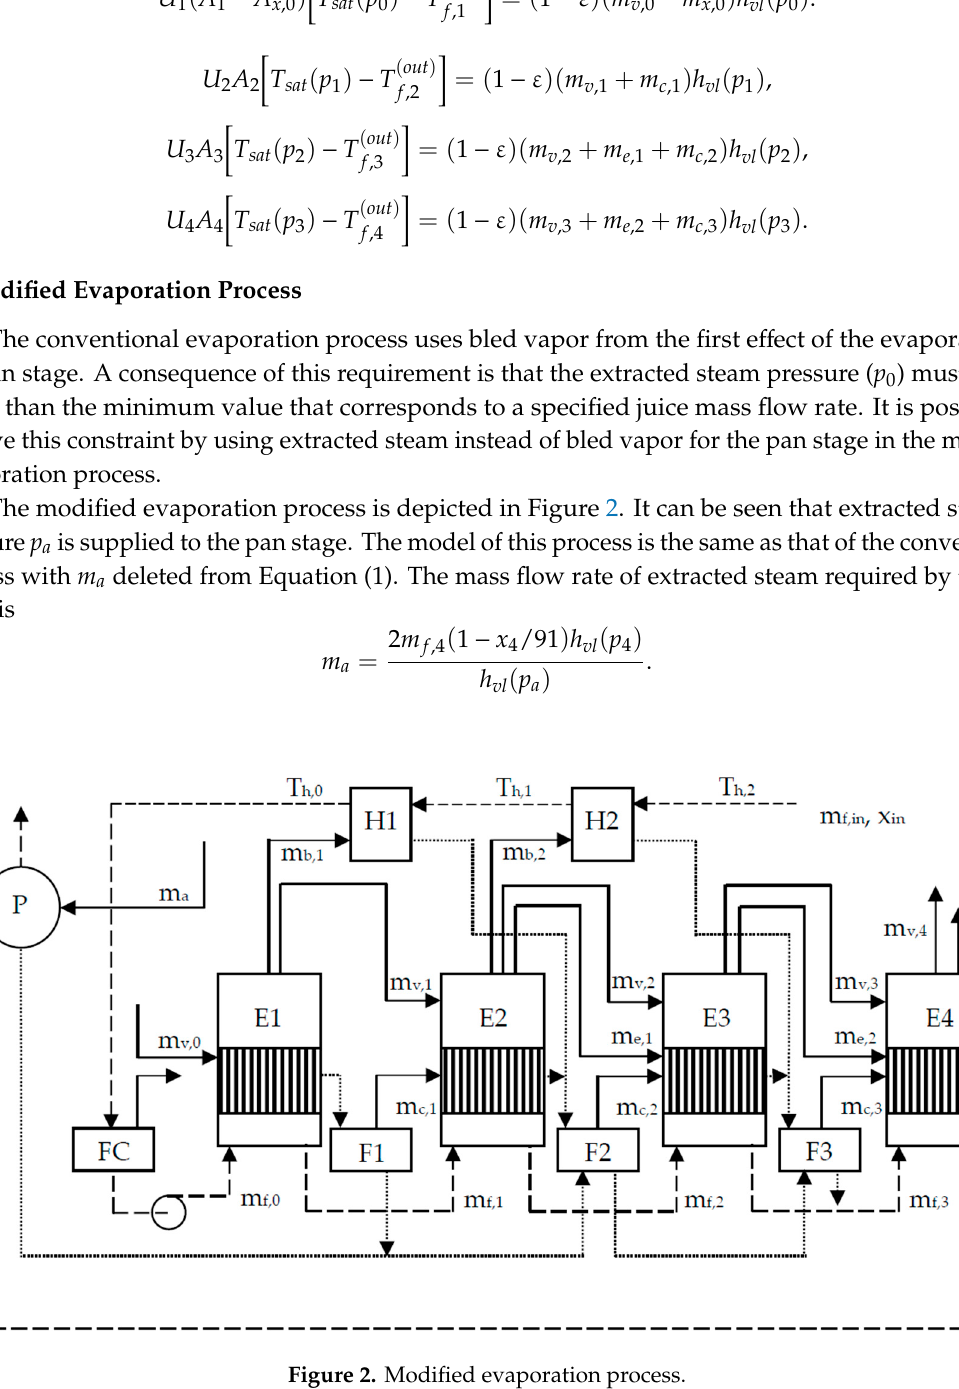
Figure 2. Modified evaporation process .